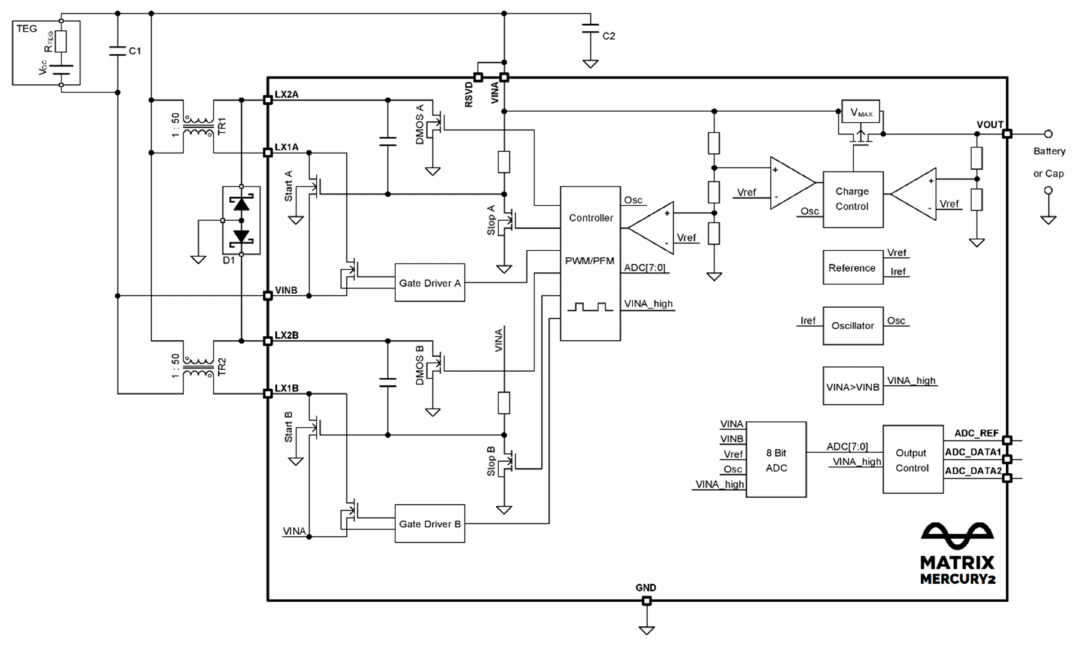
Figure 2. Block diagram of Matrix Mercury2 (this